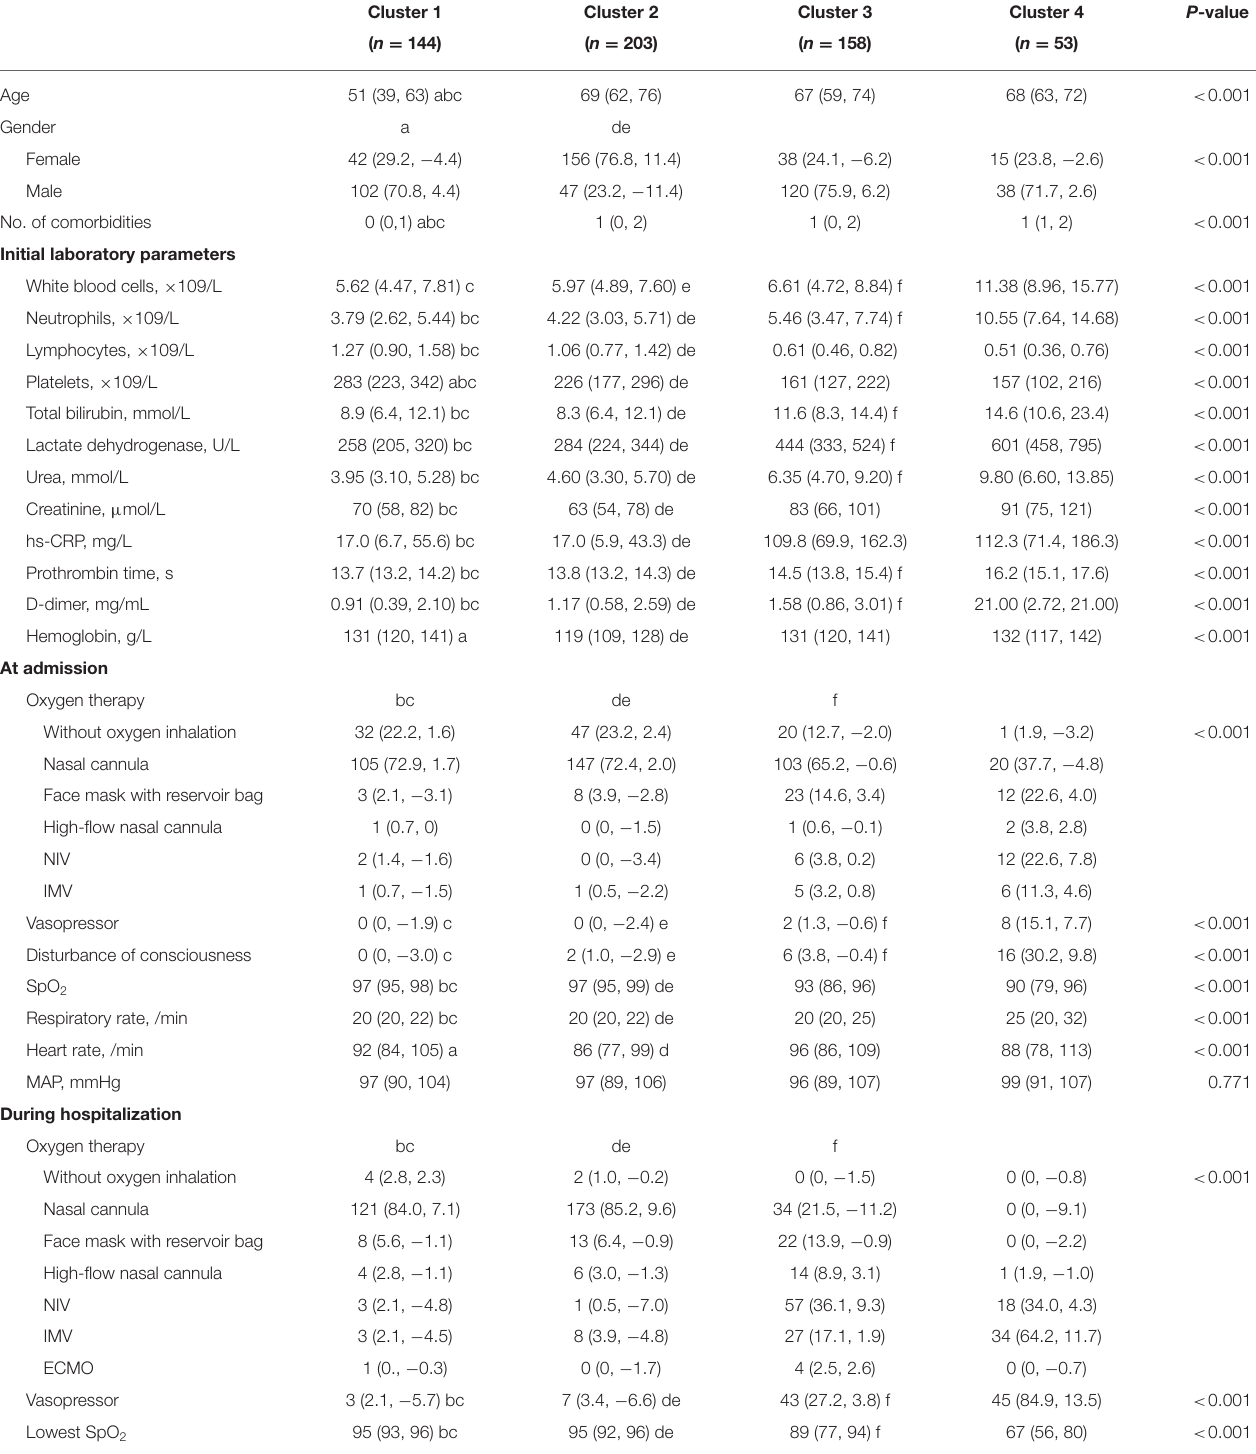
TABLE 4 | Variables included in the PAM-based clustering